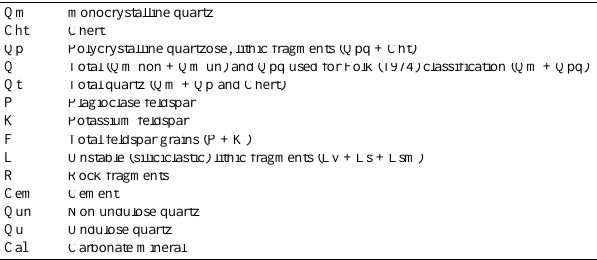
Table 1: Framework parameters of detrital